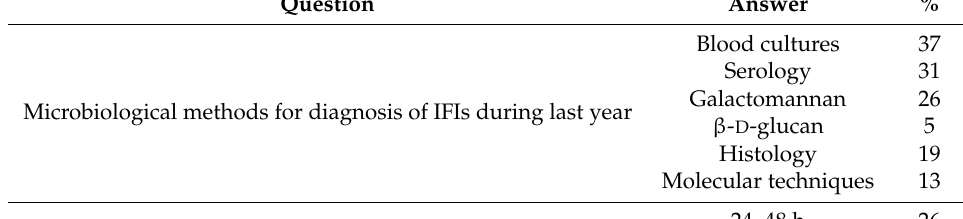
Blood cultures 37 Serology 31 Galactomannan 26 β - D -glucan 5 Histology 19 Molecular techniques 13 24–48 h 26 48 h–one week >1 week